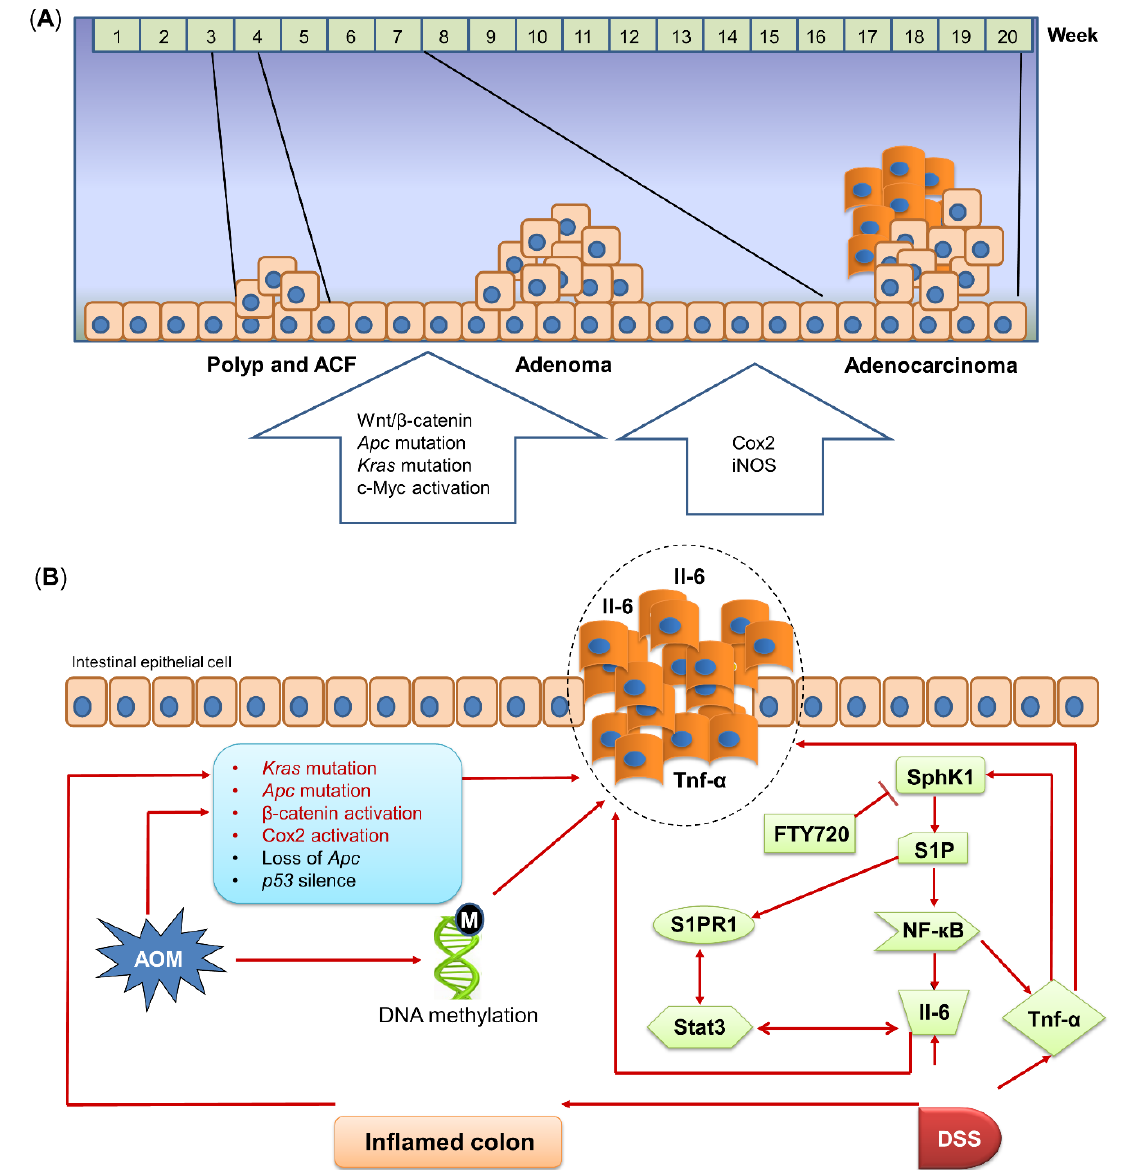
Figure 2. Mechanism of AOM/DSS-induced mouse model. ( A ) Molecular alterations in different stages of AOM/DSS-induced colon tumorigenesis. AOM/DSS treatment induces the progression from polyps/ACFs and adenomas to adenocarcinomas. Different genes are correlated with each stage of AOM/DSS-induced tumorigenesis. ( B ) Mechanism of AOM/DSS-induced colon tumorigenesis. AOM induces DNA methylation and activates or mutates cancer-related pathways to initiate tumorigenesis. DSS treatment upregulates Il-6 and Tnf- α expressions in the colon. SphK1, which is induced by Tnf- α , drives the NF- к B/Stat3 pro-inflammatory pathway to induce inflammation and promote tumorigenesis. AOM, azoxymethane; Apc , adenomatous polyposis coli; COX2, cyclooxygenase 2; DSS, dextran sulfate sodium; Il-6, interleukin-6; iNOS, inducible nitric oxide synthase; Kras , Kirsten rat sarcoma viral oncogene homolog; NF- к B, nuclear factor kappa-light-chain-enhancer of activated B cells; p53 , tumor protein p53 ; S1P, sphingosine-1-phosphate; S1PR1, sphingosine 1-phosphate receptor-1; SphK1, sphingosine kinase 1; Stat3, signal transducer and activator of transcription 3; Tnf- α , tumor necrosis factor-alpha; Wnt, wingless-related integration site. KRAS is one of the most prominent proto-oncogenes in colon tumorigenesis belong- COX2 is crucial in regulating inflammatory response and lipid metabolism. It is well ing to the RAS family, and it controls various biological processes including survival, known that inflammation is a mediator of colon tumorigenesis [34], whereas altered growth, proliferation, differentiation and apoptosis [26]. Activation of KRAS is associated